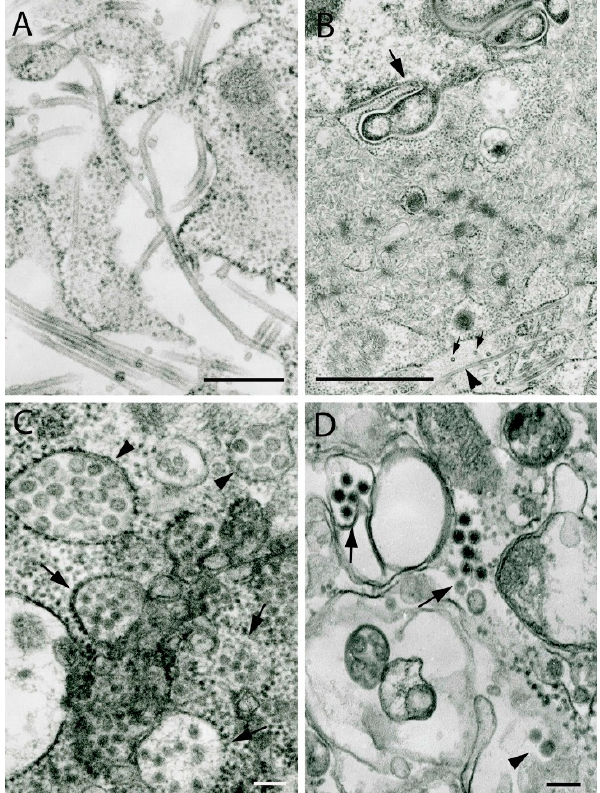
Figure 9. Ultrastructural cytopathology and mixed virus infections. ( A ) Enormous expansion of perinuclear space in a C6 / 36 cell infected with Loreto virus (strain 3940-83; unclassified, proposed genus Negevirus ). Perinuclear space is filled with long tubules (up to several micrometers) ~30 nm in diameter. Bar = 0.5 µ m. ( B ) Fragmentation of the cell nucleus (large arrow) and enormous expansion of perinuclear space-endoplasmic reticulum complex filled with tubules which can be very long (up to 1.3 um, arrowhead). Small arrows indicate cross-sections of the tubules ~25 nm in diameter. C6 / 36 cell is infected with BC 2-5 virus (unclassified; proposed genus Negevirus ). Bar = 1 µ m. ( C ) Mixed infection of a C6 / 36 cell with Karang Sari virus (strain JKT-10701; probable genus Alphamesonivirus ) (arrowheads indicate virions 55 nm in diameter inside ER) and a flavivirus (arrows indicate virions 40 nm in diameter inside ER). Bar = 100 nm. ( D ) Mixed infection of a C6 / 36 cell with Kamphaeng Phet virus (strain KP84-0156; unclassified, probable genus Alphamesonivirus ) (virions 55 nm in diameter indicated with an arrowhead) and a reovirus (45 nm in diameter, arrows). Bar = 100 nm.